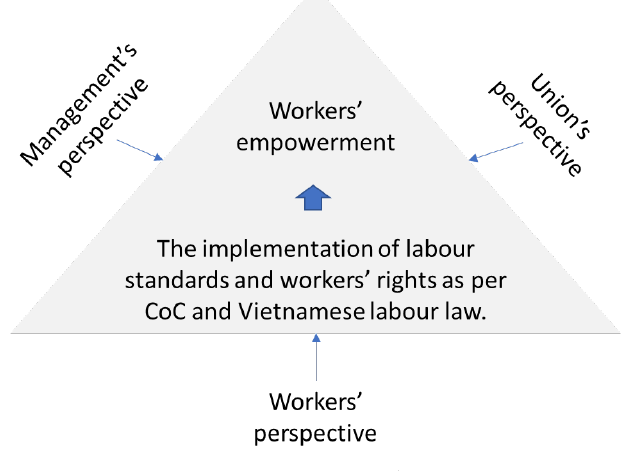
Figure 2. Data Figure 2. Data triangulation.